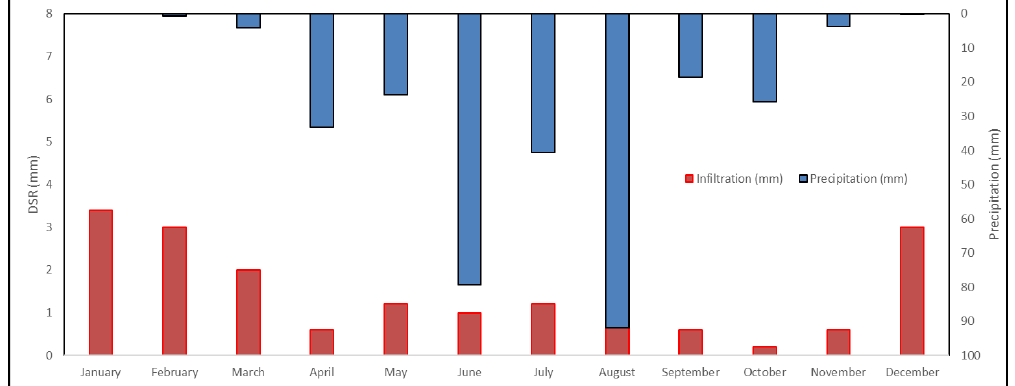
Figure 10. Every month add together. Water 2020 , 12 , x FOR PEER REVIEW